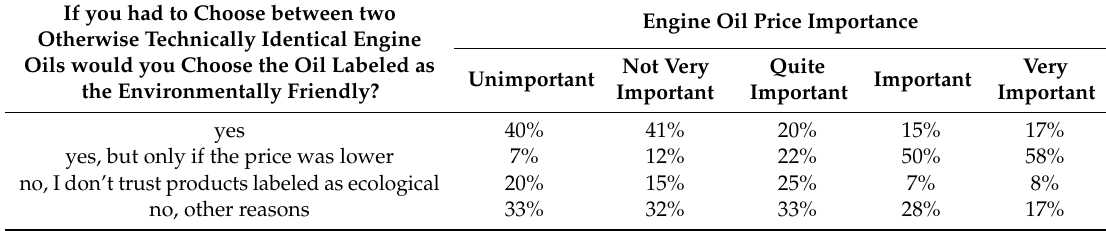
Table 1. Distribution of drivers’ propensity to buy environmentally friendly engine oil conditionally on the declared importance of the low oil price.